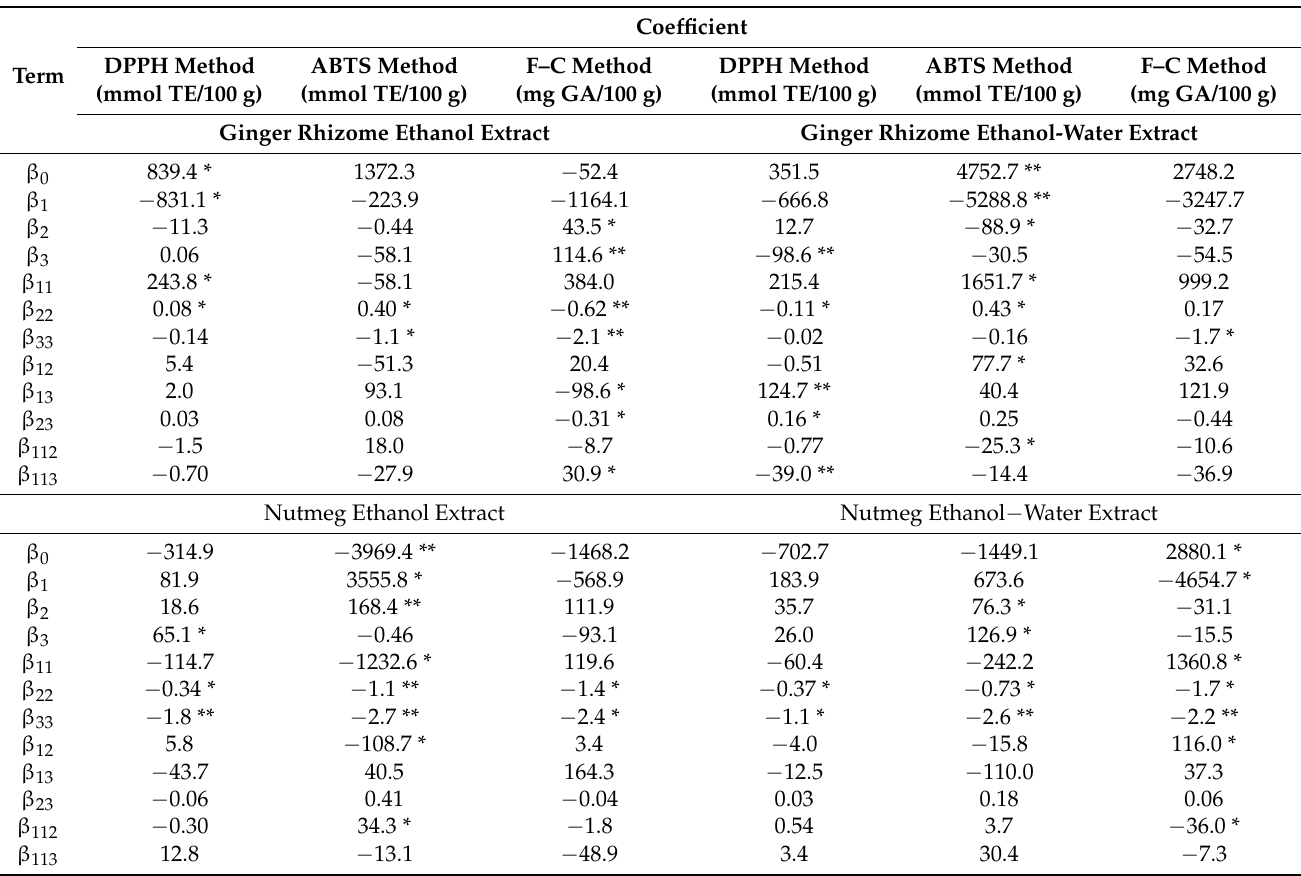
Table 3. Regression coefficients of the partial cubic model for the antioxidant properties of ginger rhizome and nutmeg